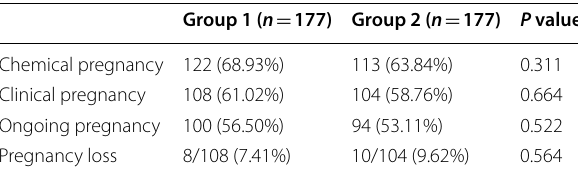
Table 3 Clinical outcomes in both